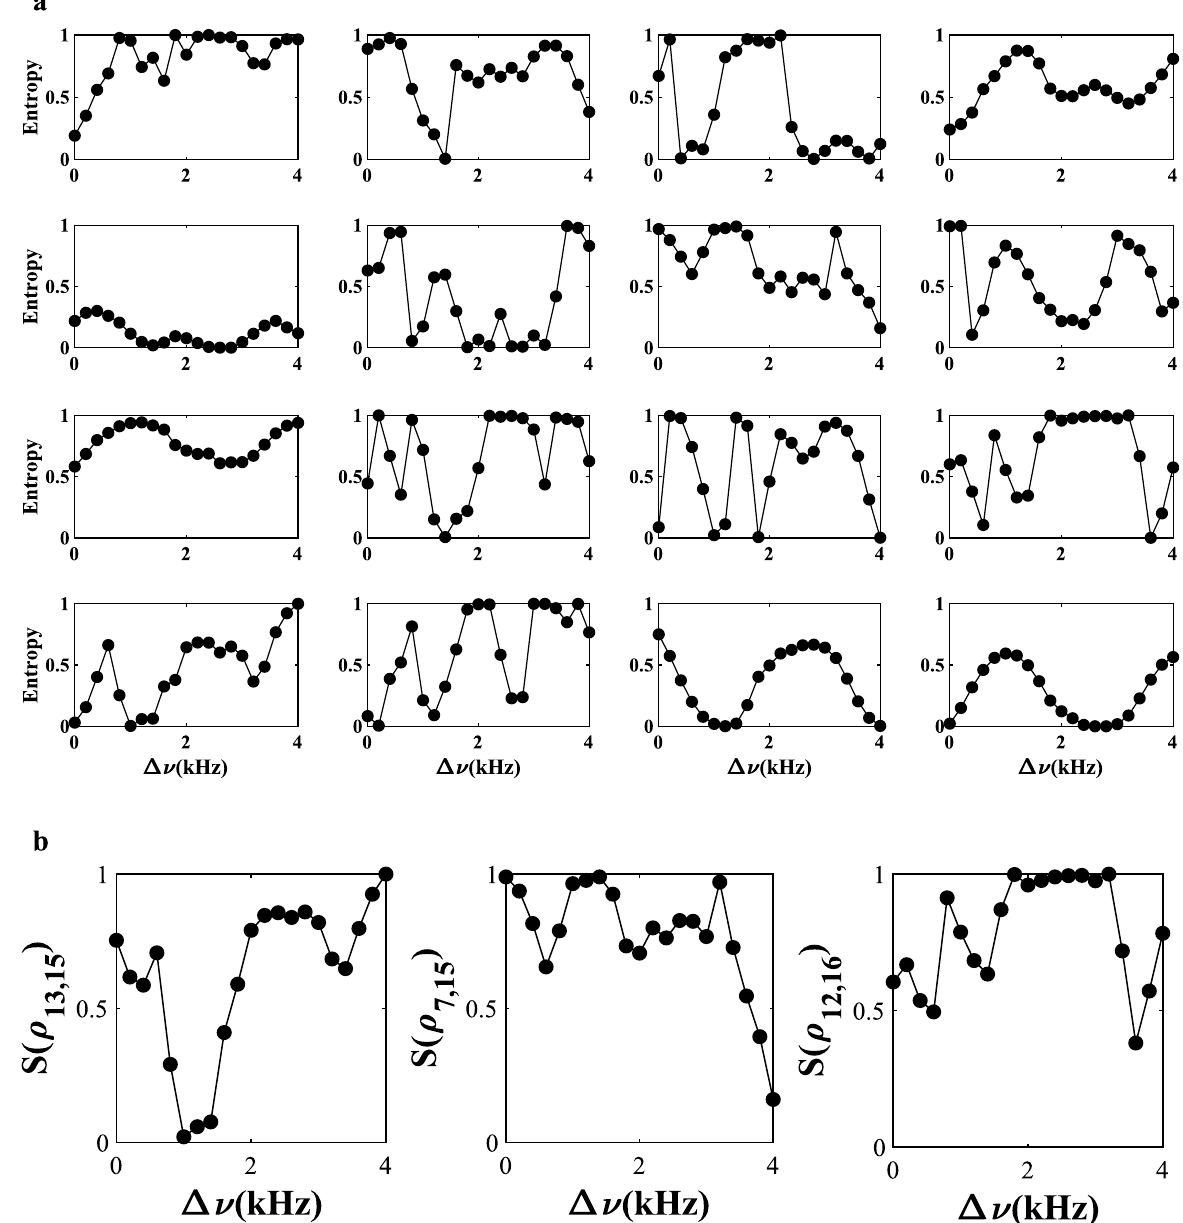
Figure 5. N = 16 entropy of entanglement. Variations in the entropy of entanglement of the 16 phi-bits system. The entropy is normalized to log2 . ( a ) 1–15 partition i.e., entropy of entanglement is calculated by taking the partial trace over one phi-bit subsystem ( S (ρ 1 ) , S (ρ 2 ) , . . . , S (ρ 16 )) . The entropy of entanglement of 1–15 phi-bit partitions are shown from top left (phi-bit 1) to bottom right (phi-bit 16). ( b ) 2–14 partition i.e., entropy of entanglement is calculated by taking the partial trace over two phi-bit subsystems